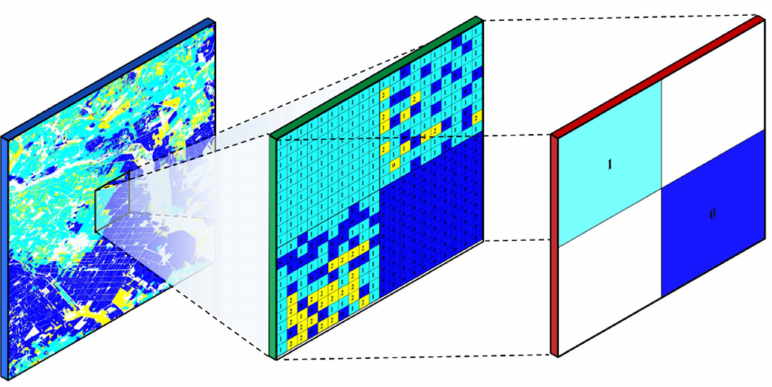
Figure 4. Pure pixel crop label